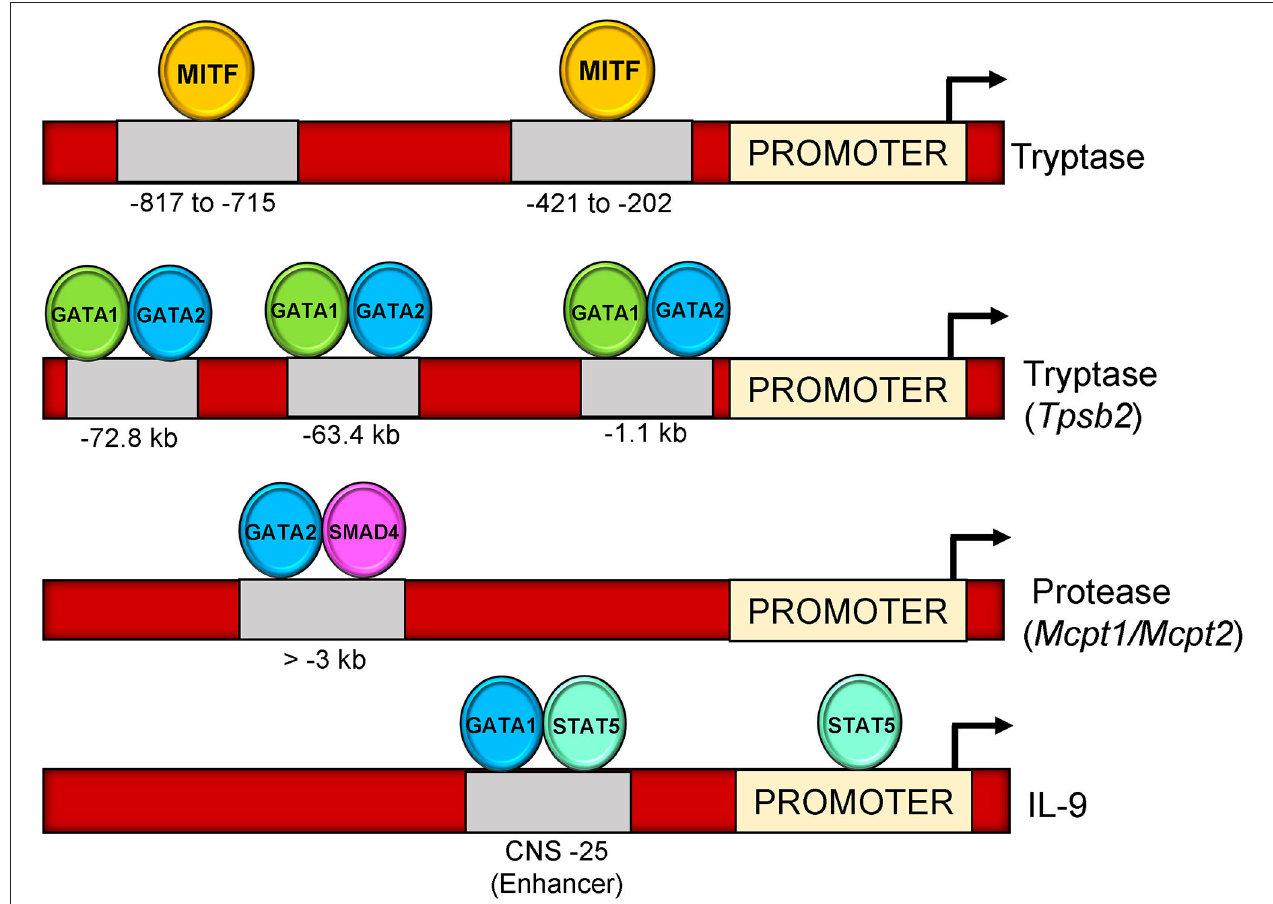
FIGURE 2 | Binding sites of transcription factors on mast cell genes (Tryptase, Tpsb2, Mcpt1, Mcpt2, and IL-9). MITF binds on two locations upstream of tryptase gene promoter ( − 817–715 and − 421–202) on E-box motif (CACCTG). GATA1 and GATA2 bind three locations upstream of Tpsb2 gene ( − 72.8, − 63.4, and,1.1kb). GATA2-SMAD4 occupy a region at > -3kb upstream of Mcpt1/Mcpt2 promoter. GATA1-STAT5 bind to a CNS-25 regulatory region at IL-9 gene